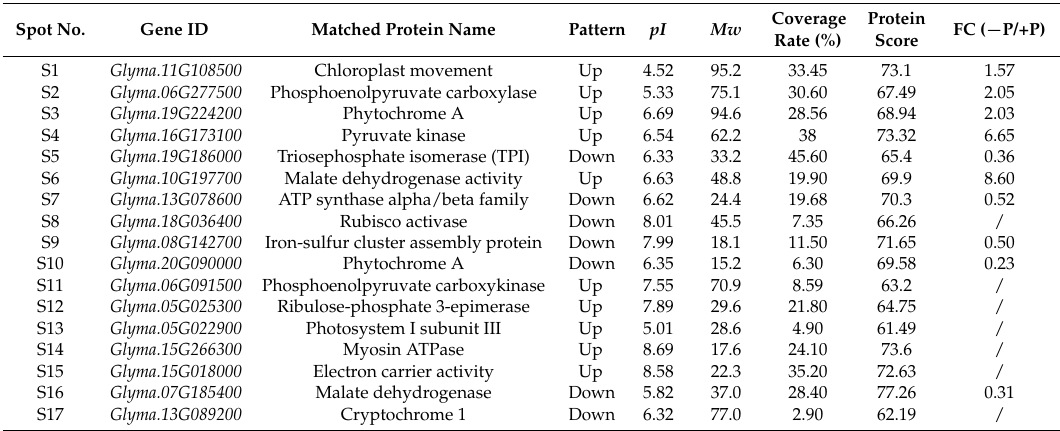
Table 3. List of 17 photosynthetic related proteins with significantly different abundance in the leaves of soybean in response to low-P stress.